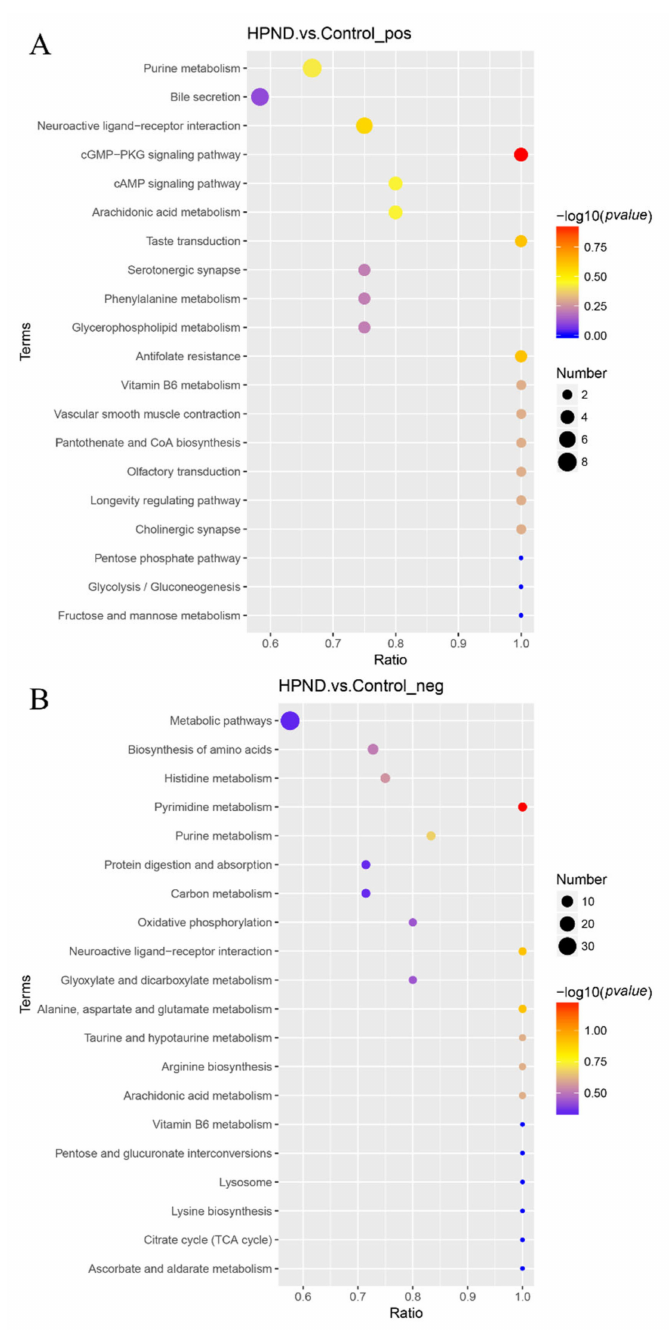
Figure 5. Top 20 KEGG pathways significantly enriched with differentially expressed metabolites (( A ) POS mode; ( B ) NEG